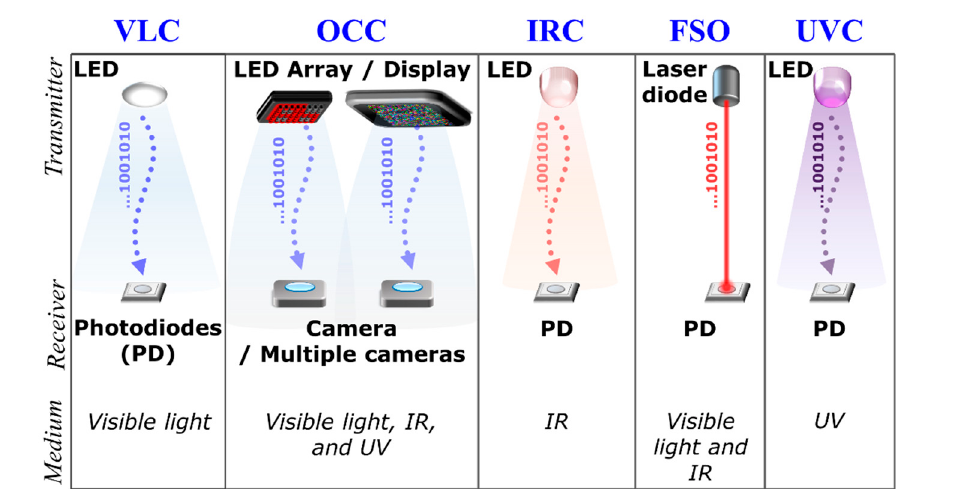
Figure 1. The electromagnetic spectrum.